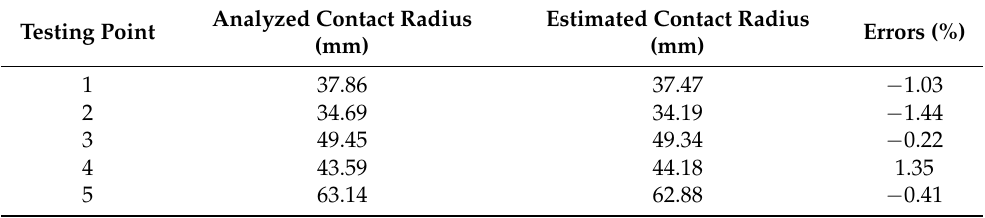
Table 5. The error of contact radius estimated by the Kriging interpolation